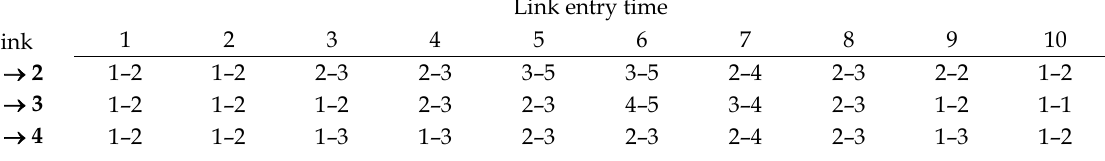
Four-node, two-route downstream network Min–max predicted link traversal time when entering link at given entry time Link entry Link